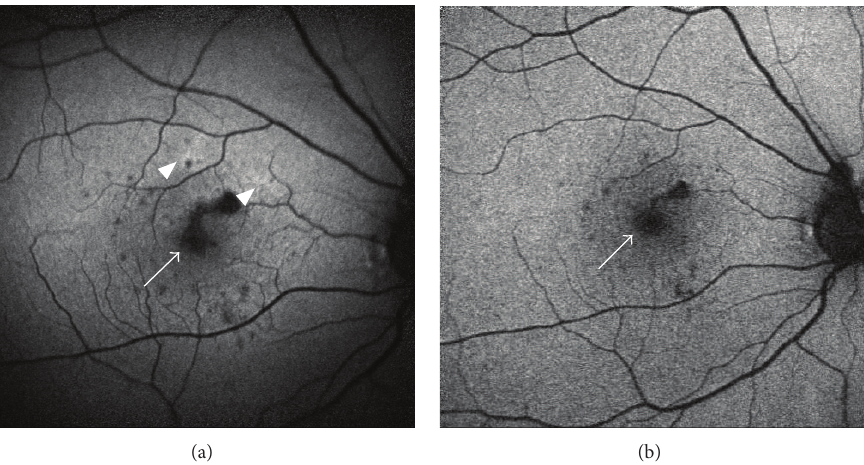
Figure 2: Fundus autofluorescence (FAF) images of a young female with punctate inner choroiditis. (a) FAF shows hyperautofluorescence halos (arrow heads) and multiple hypoautofluorescent spots (arrow). The spots are surrounded by a hyperautofluorescent halo, denoting continued cellular damage and ongoing active inflammation. (b) FAF captured 5 months after immunosuppression was started shows diminished hyperautofluorescence and less hypoautofluorescent spots.